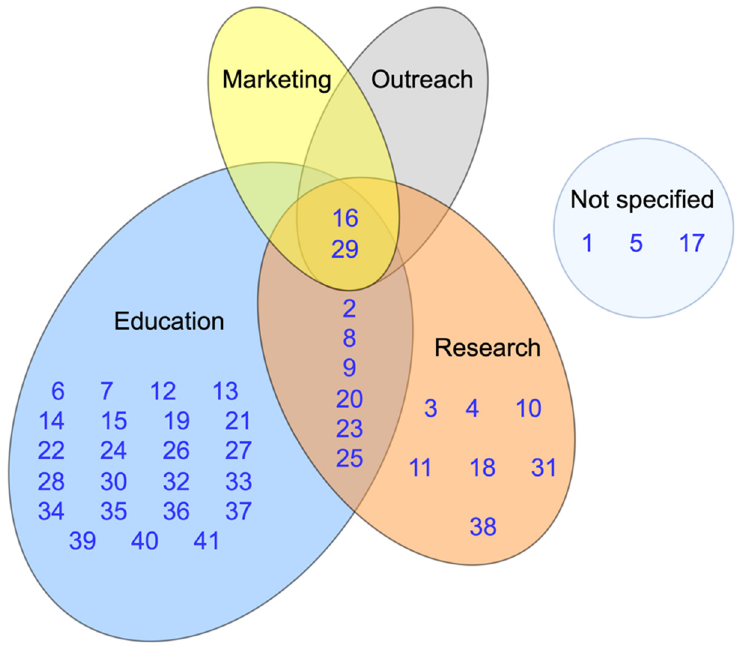
Figure 3. Target sector of the described applications. Numbers 1 to 41 identify the works listed in Table 4 (column “Work Number”).